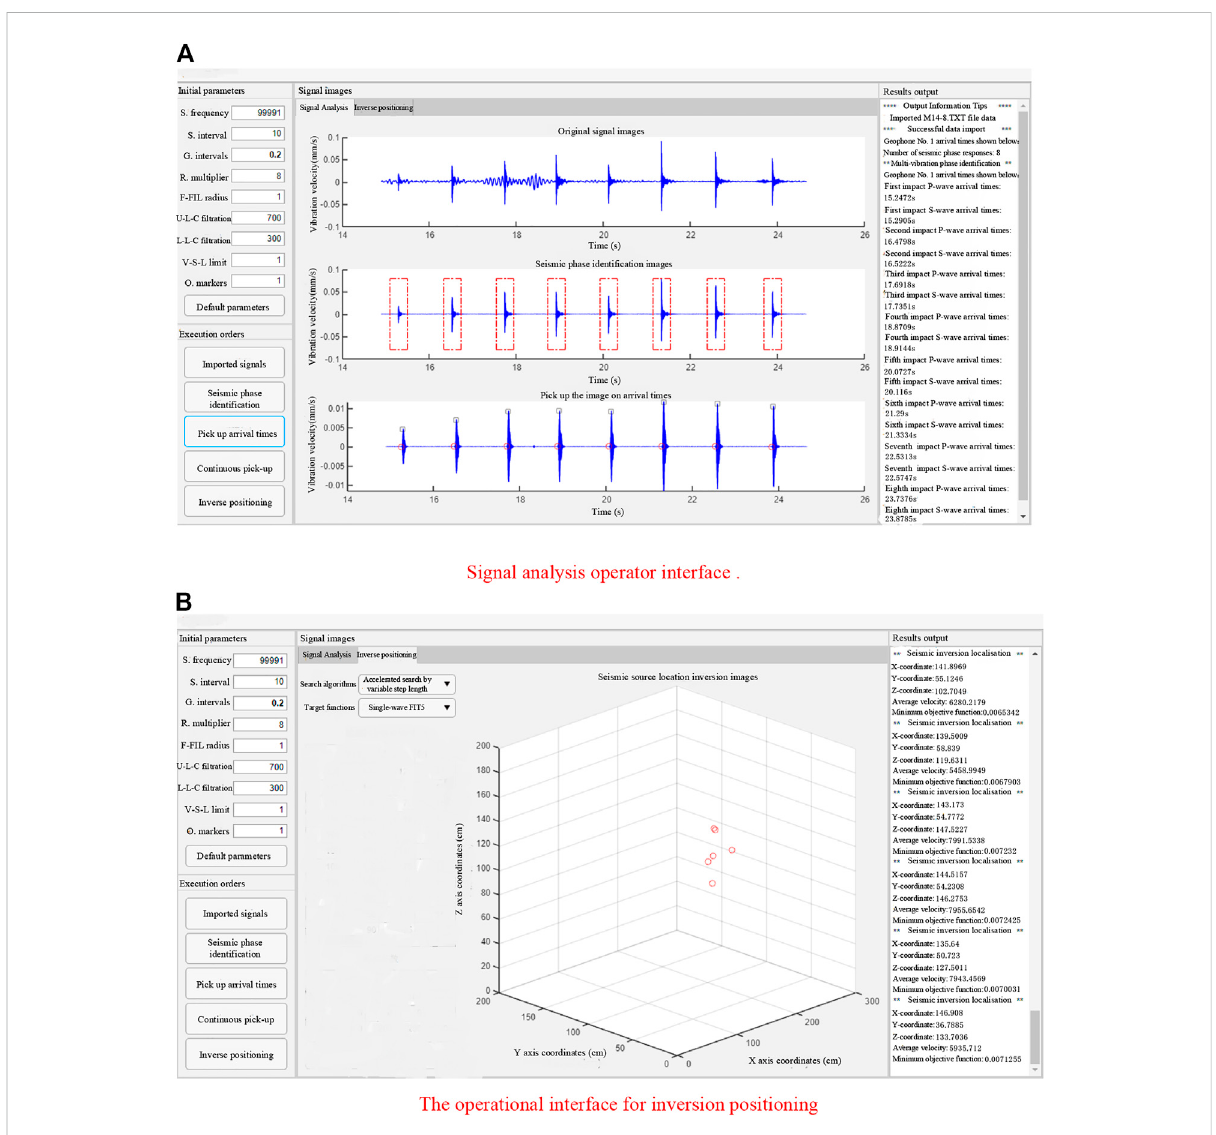
FIGURE 8 Integrated software graphical user